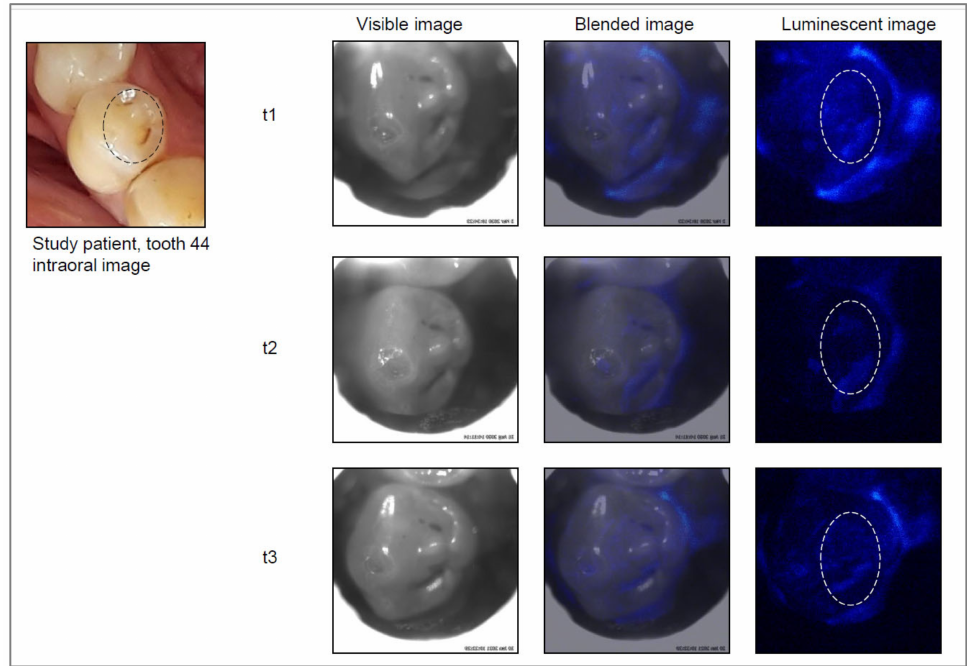
Figure 2. Example of a study tooth (lower right premolar) with an active lesion at all visits: t1 = base- line, t2 = six months after baseline, t3 = twelve months after baseline.